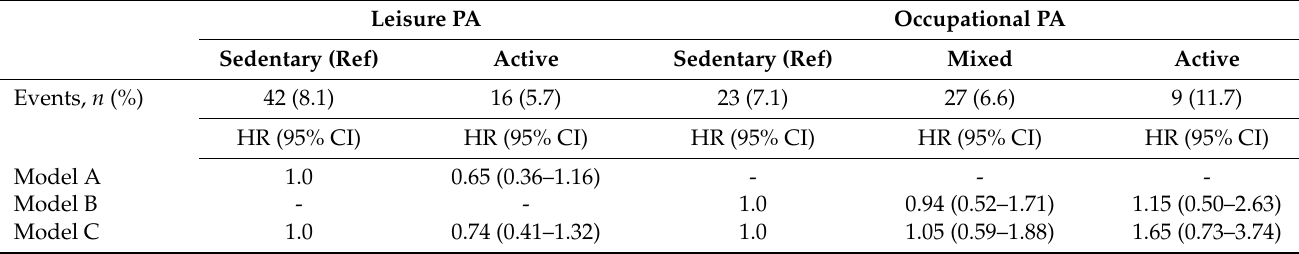
Table 2. Cox proportional hazards for self-reported physical activity, n = 798 and 58 events (due to missing self-reported leisure time physical activity).